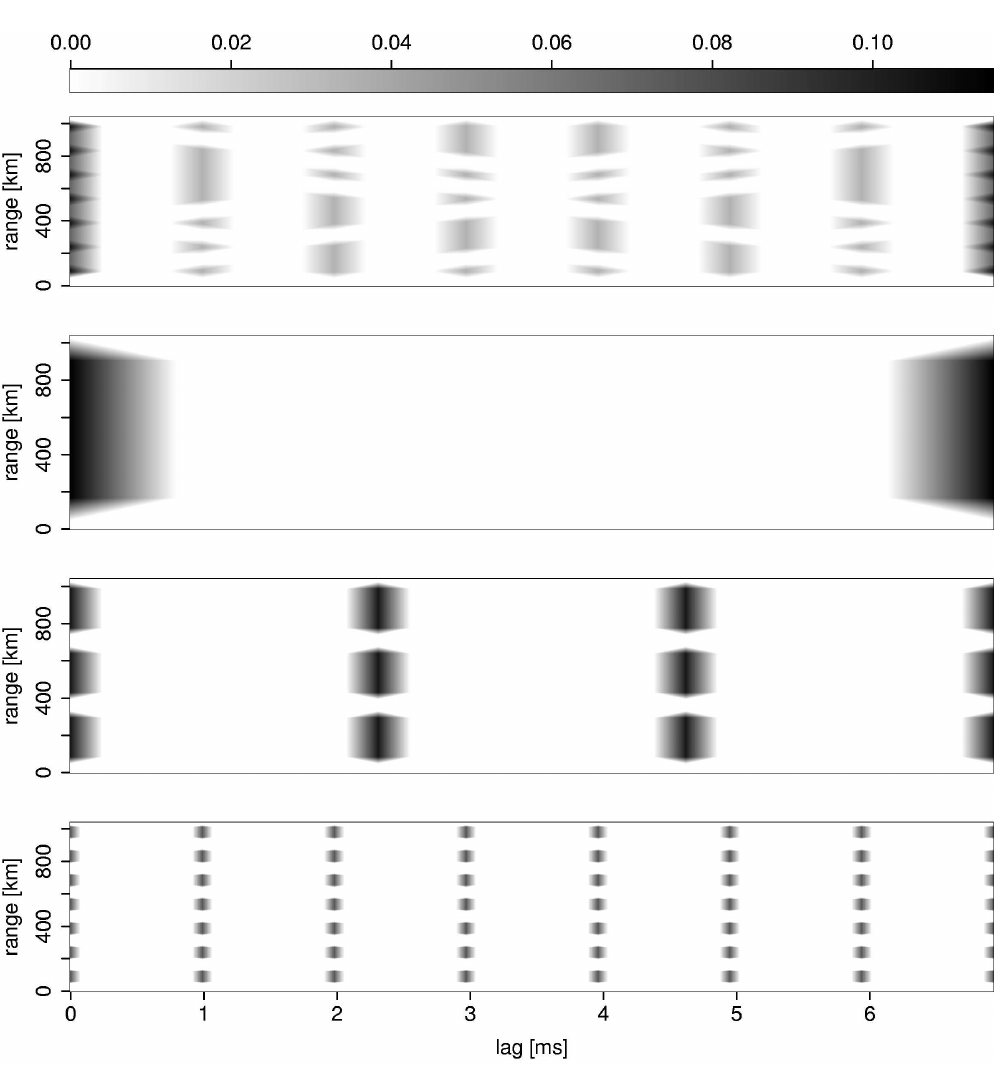
Fig. 2. Absolute radar efficiencies as functions of range and lag for the experiments compared in this paper. Following the names in Table 2, the efficiency of the PPATC experiment is plotted in the top panel, exp1 in the upper middle panel, exp2 in the lower middle panel and exp3 in the bottom